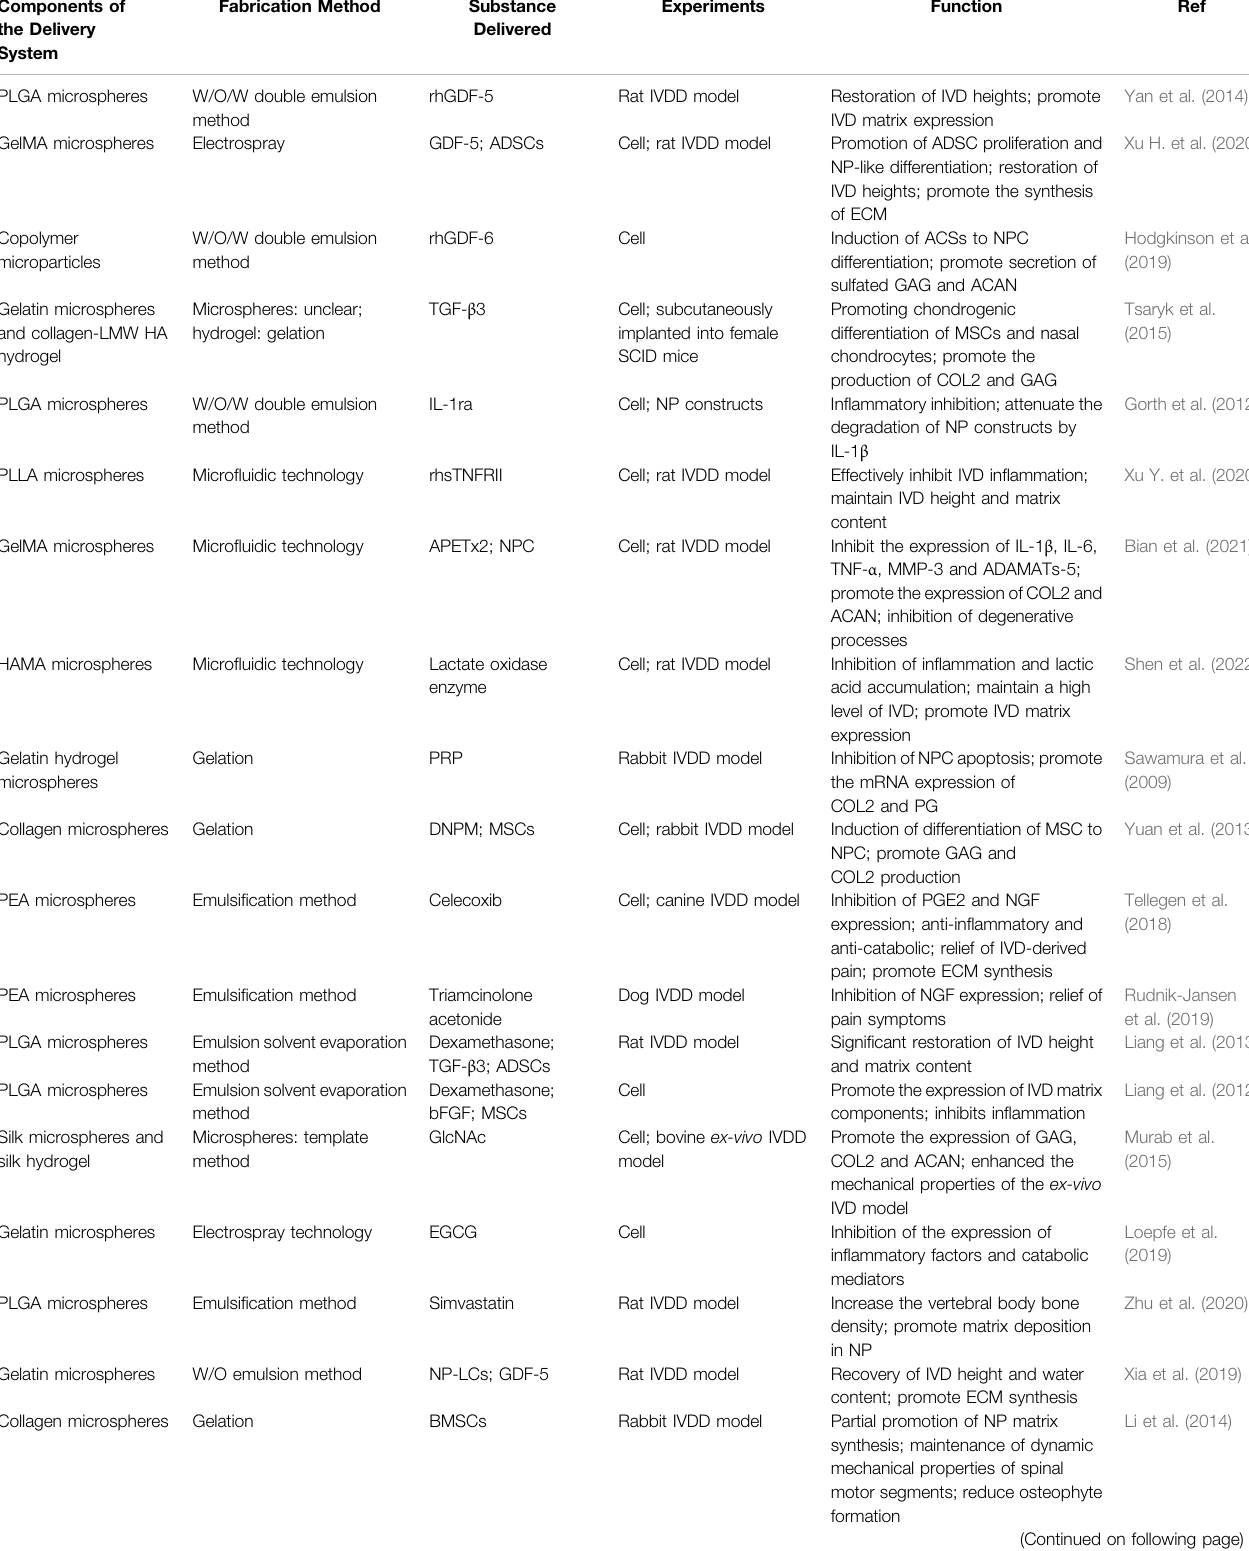
TABLE 2 | Application of microsphere-based delivery systems in